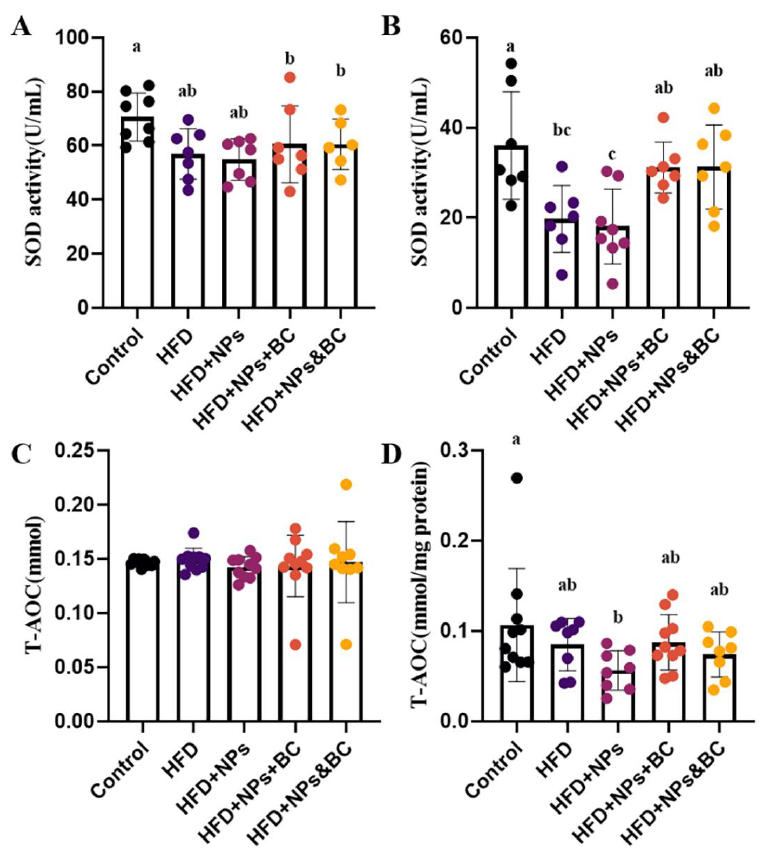
Figure 3. The effects on the antioxidant ability in serum and colon tissues of mice. ( A ) The SOD activities in serum, ( B ) the SOD activities in colon tissues, ( C ) the T-Aoc levels in serum, and ( D ) the T-Aoc levels in colon tissues. The different letters represent significant differences among groups ( p < 0.05).